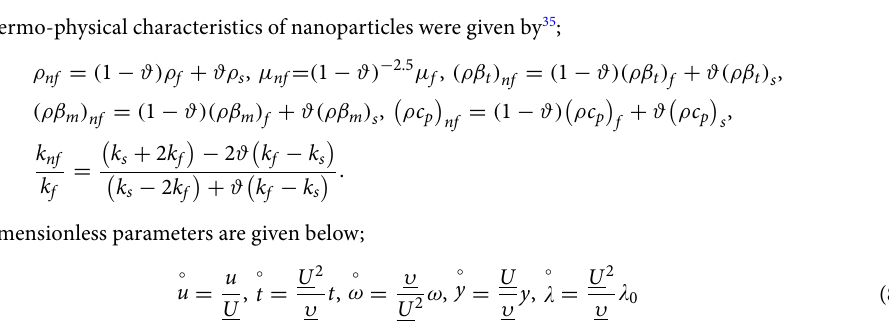
The thermo-physical characteristics of nanoparticles were given by 35 ;